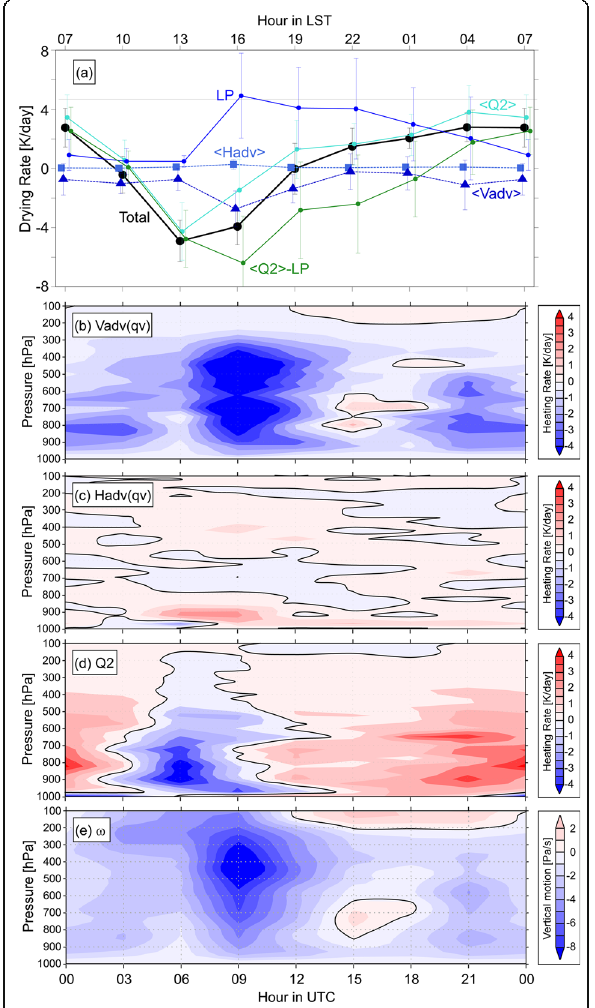
Fig. 9 Diurnal composite of each term in the thermodynamic budget analyses, for moisture; a is for the vertically integrated values of each of the terms in the thermodynamic budget analyses. Lines are labeled by strings with the same color. The black thick line with labeled “ Total ” is the time derivative for the amount of moisture. Broken lines labeled “ <Hadv> ” and “ <Vadv> ” are for the array-scale horizontal and vertical advection terms, respectively. The 95% confidence intervals are showed by thin vertical bars for each value and each timestep. b to e are in the time – pressure cross section, for b array-scale vertical advection, c array- scale horizontal advection, d Q2 , and e the array-scale vertical air motion in pressure coordinates. Note that all of the values are positive for the heating or drying of the atmosphere (troposphere)